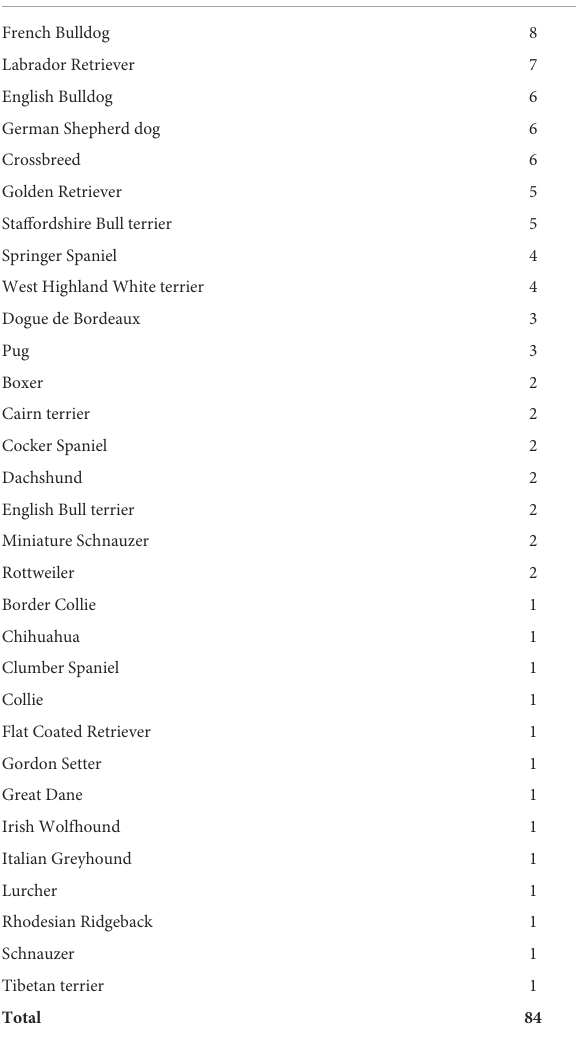
TABLE 1 Description and frequency of the different dog breeds. Breed